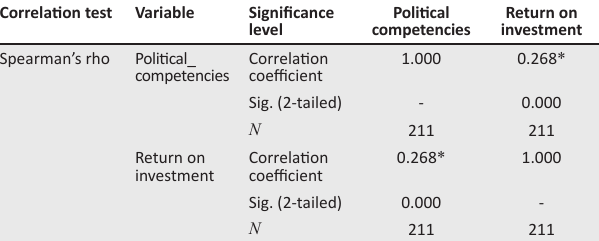
TABLE 3: Spearman’s correlation on managerial political competencies versus innovation. Correlation test